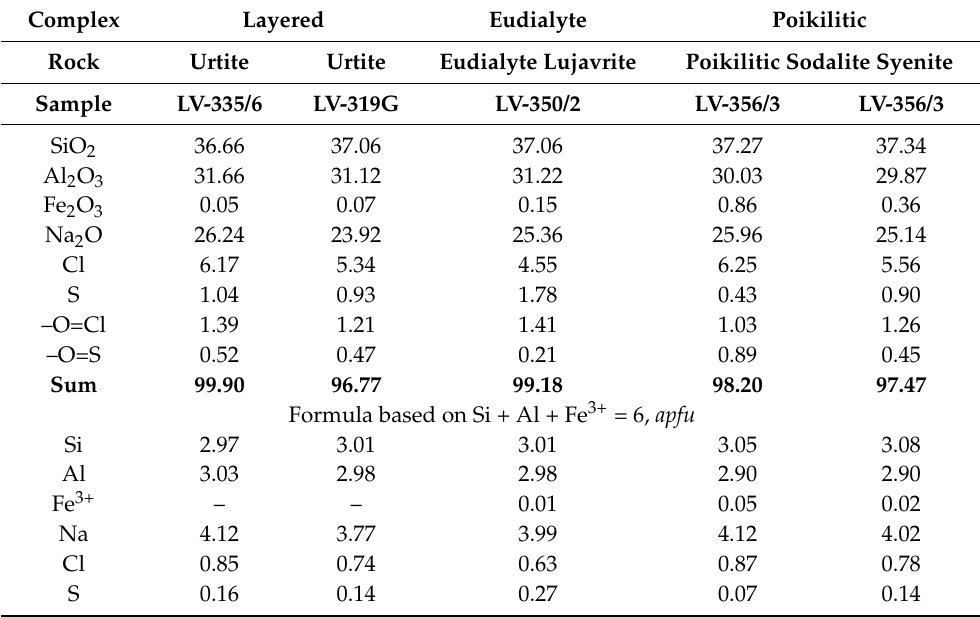
Table 5. Representative chemical analyses of sodalite from Lovozero rocks (microprobe,